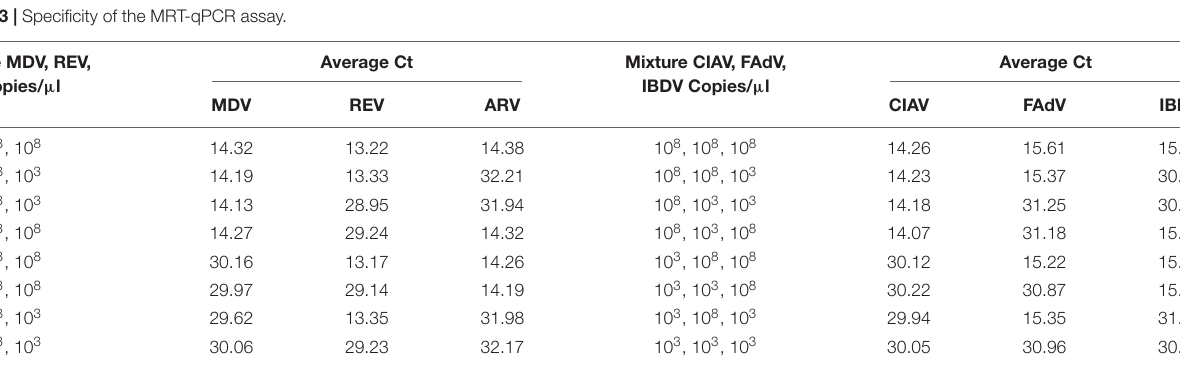
FIGURE 2 | Detection of specificity and repeatability of the MRT-qPCR assay. (A) Gel electrophoresis of MRT-qPCR products produced with pairs of primers for MDV, REV, ARV, CIAV, FAdV, or IBDV. (B) Repeatability of the MRT-qPCR assay over three independent tests using three different mixtures of each standard plasmid. The high concentration mixture was composed of 10 8 copies/ µ l of each standard plasmid, the medium concentration mixture was composed of 10 6 copies/ µ l of each standard plasmid, and the low concentration mixture was composed of 10 4 copies/ µ l of each standard plasmid. TABLE 3 | Specificity of the MRT-qPCR